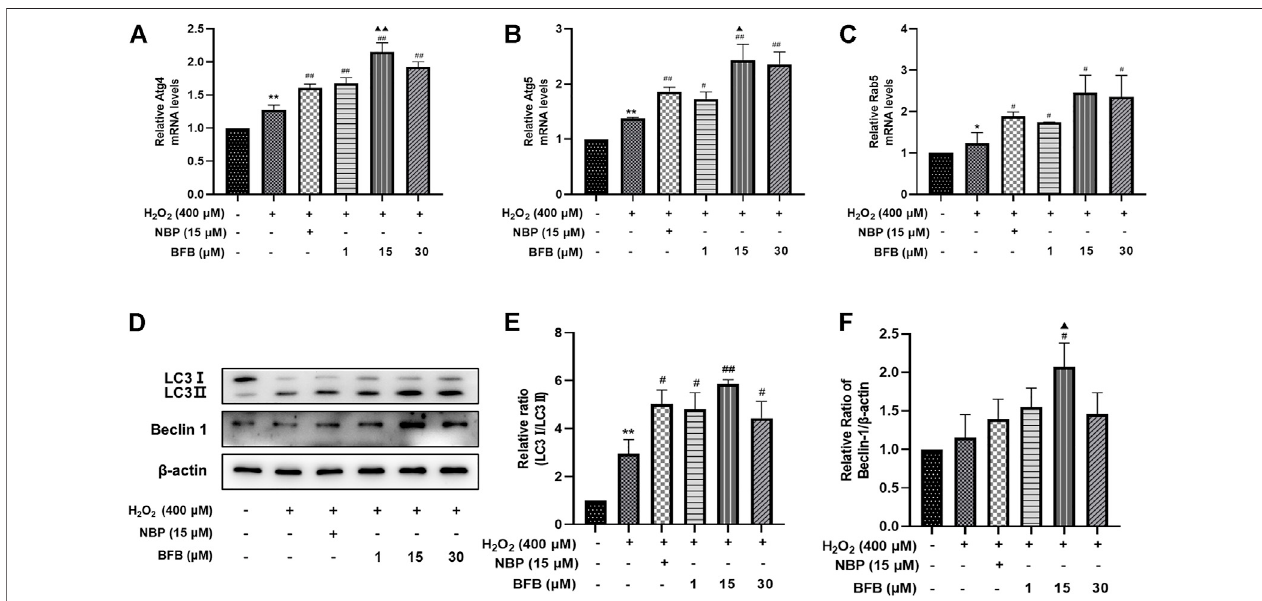
FIGURE8| BFBinhibitsoxidativestressbyinitiatingandinducingautophagyofH 2 O 2 -mediated PC12cells (A – C) Autophagy-associatedgenelevels(Atg4,Atg5, Rab 5) were tested respectively via RT-qPCR (D,E) The autophagy-associated proteins expression (LC3, Beclin-1) was measured via WB. Data were represented by mean ± SD of 3 separate assays. * p < 0.05, ** p < 0.01, versus Control, # p < 0.05, ## p < 0.01, versus H 2 O 2 group. ▲ p < 0.05, ▲▲ p < 0.01, versus NBP